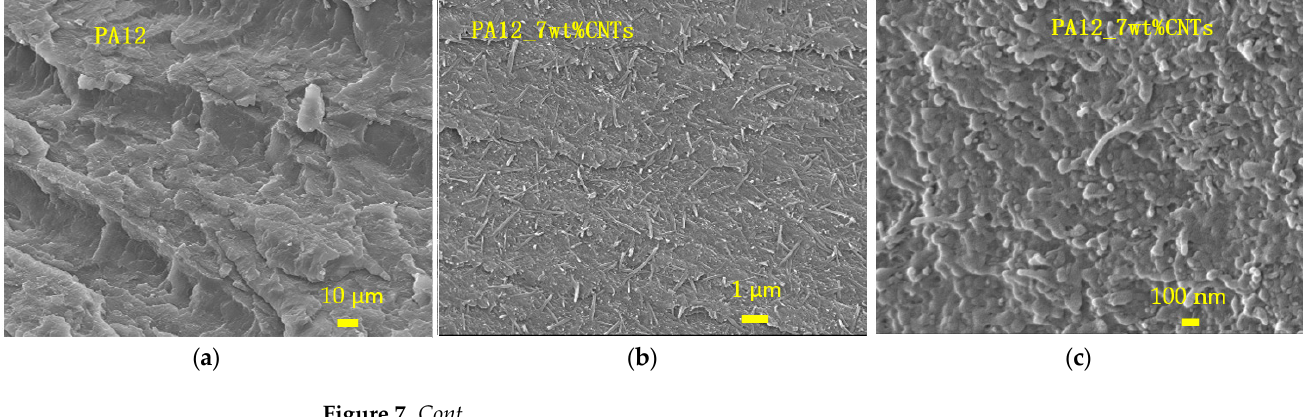
Figure 6. The fabricated coupons of PA12 and PA12 with 10% and 20% inclusions of CNTs@chopped CFs.